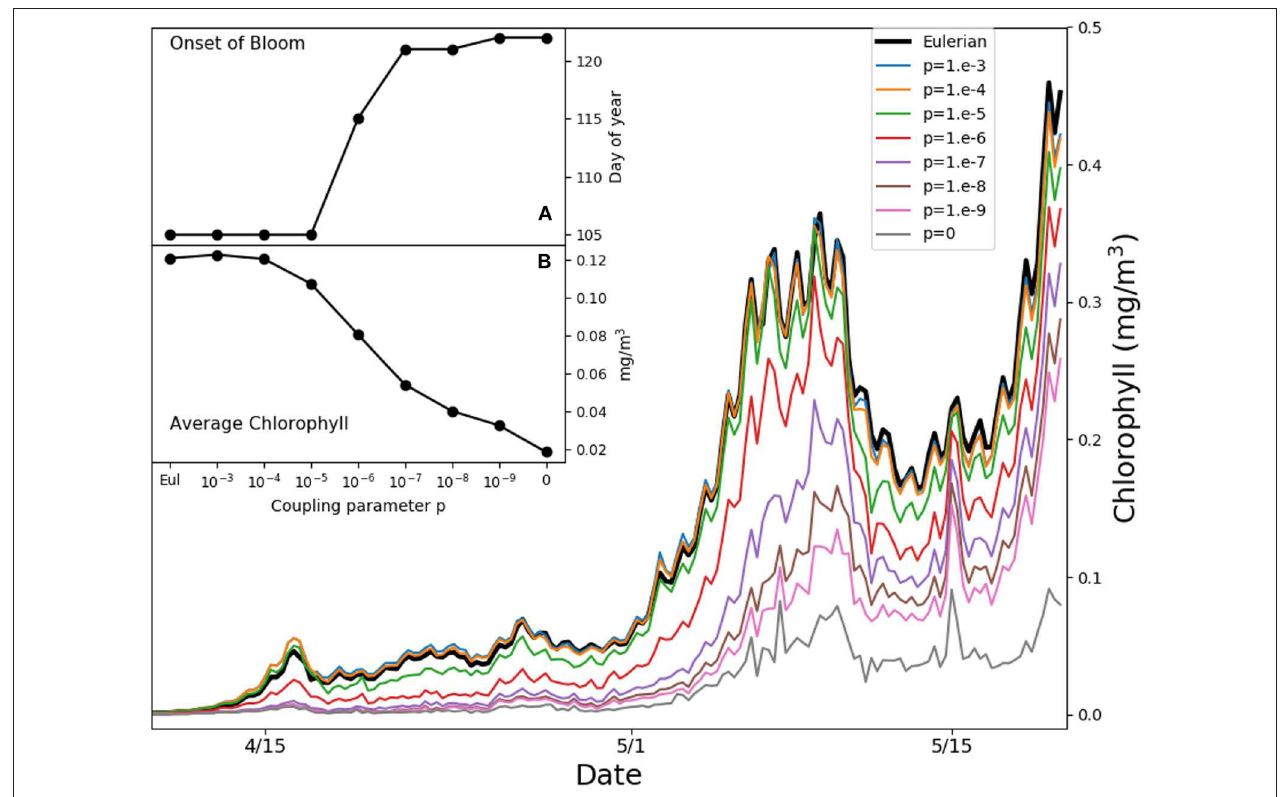
FIGURE 5 | Average chlorophyll in the first 50 m of water column for the simulated Ocean Station PAPA in the North-West Pacific. Thin colored lines refer to aquacosm simulations coupled with varying strength p . The thick back line refers to the eddy-diffusive Eulerian model. Inset (A) shows the day of the onset of the bloom (see main text); inset (B) shows the average chlorophyll in the period April 15th to May 15th, both of them plotted as functions of the coupling